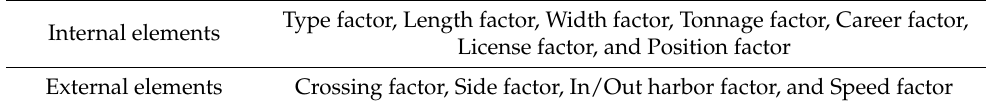
Table 1. Internal and external elements considered in the PARK model.